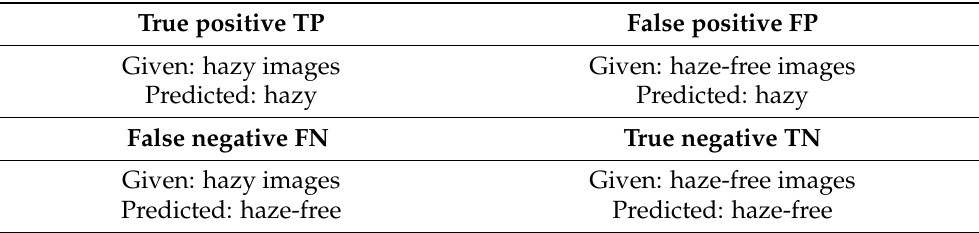
Table 3. Summary of terminologies and derivations for evaluating the hazy/haze-free image classifi- cation